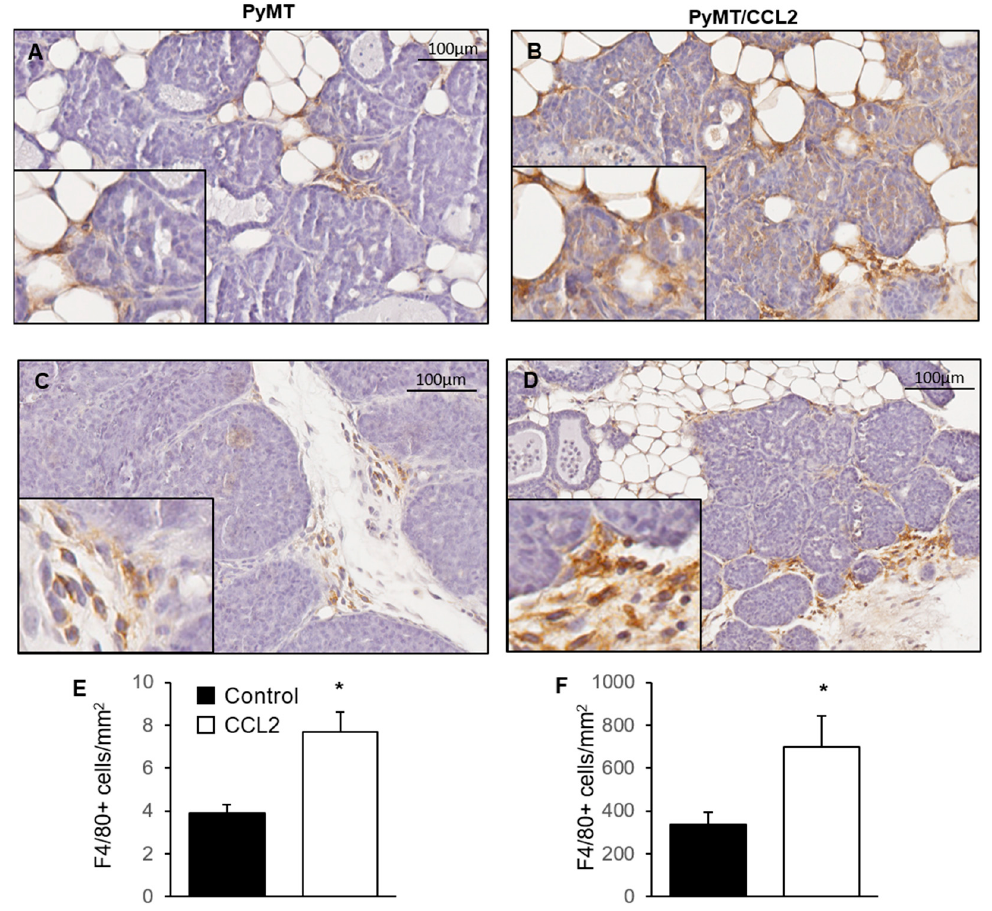
Figure 6. The effect of CCL2 overexpression on macrophage abundance in mammary tumours in 9- week-old PyMT transgenic mice. Representative images of F4/80 stained mammary glands of 9-week-old ( A , C ) PyMT and ( B , D ) PyMT/CCL2 mice in areas of ( A , B ) early tumorigenesis and ( C , D ) the primary tumour. Images were taken at 20× magnification with 40× inserts. F4/80+ cells were manually counted in 3 areas of ( E ) early tumorigenesis or ( F ) primary tumour ( n = 10 per group). Arrows indicate F4/80+ stained cells. Data presented as mean F4/80+ cells per mm + SEM with sta- tistical analysis performed using a simple linear regression with Wald Chi square post hoc compar- ison. Statistical significance indicated by * when p < 0.05.